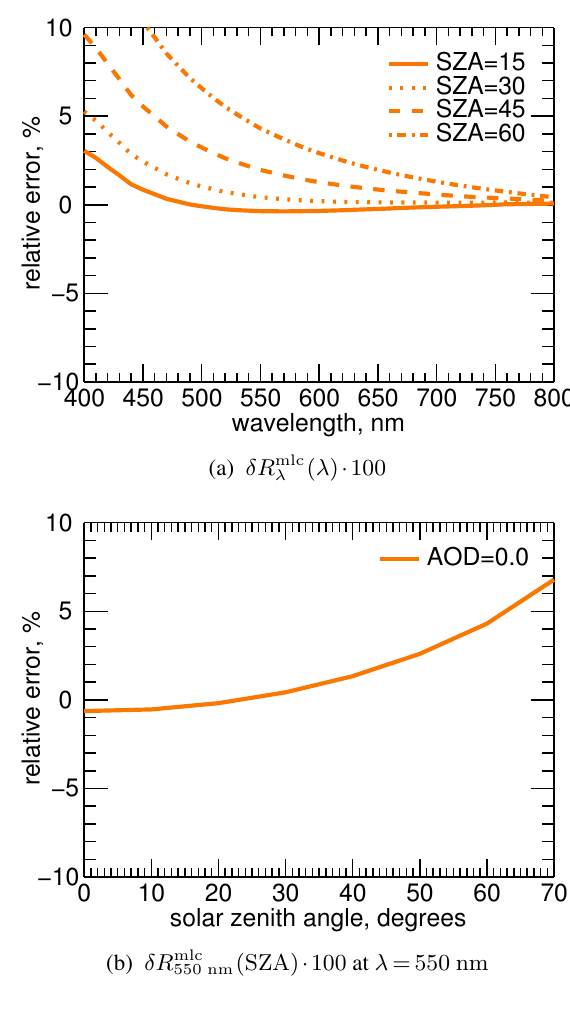
Fig. 2: Percent error due to Rayleigh scattering and polarisa- Fig. 2. Percent error due to Rayleigh scattering and polarisation tion with respect to wavelength and solar zenith angle (SZA) with respect to wavelength and solar zenith angle (SZA) at top-of- at top-of-atmosphere.